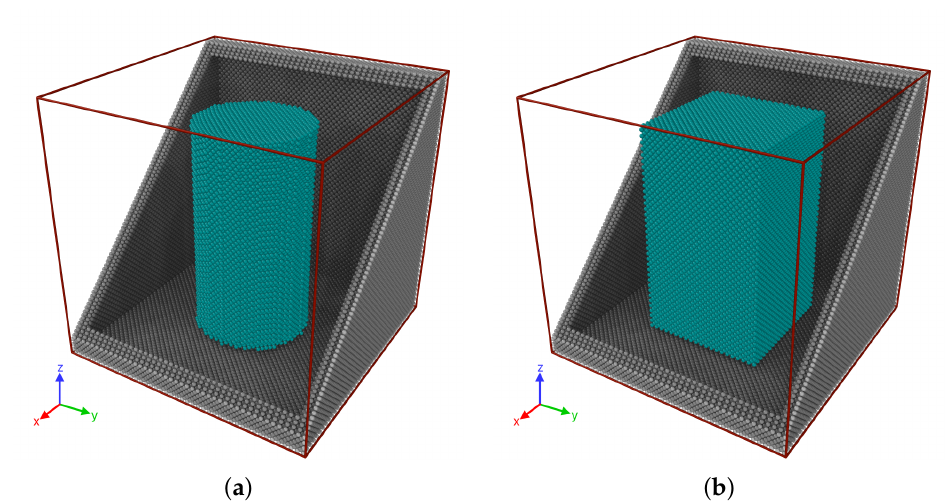
Figure 30. General view of particles configuration for the substance column collapse. Wall particles shown in dark-grey; substance particles shown in light blue. Cutting plane only for visualisation. ( a ) Cylindrical column. ( b ) Prismatic